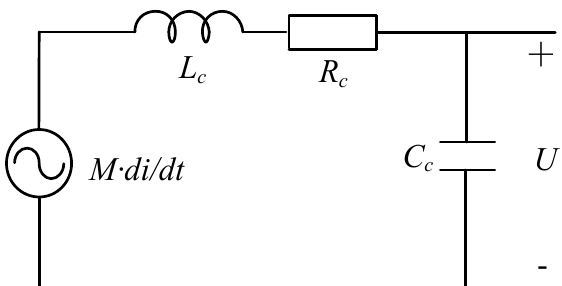
Figure 3. lumped parameter model of Rogowski coil. Figure 3. Lumped parameter model of Rogowski